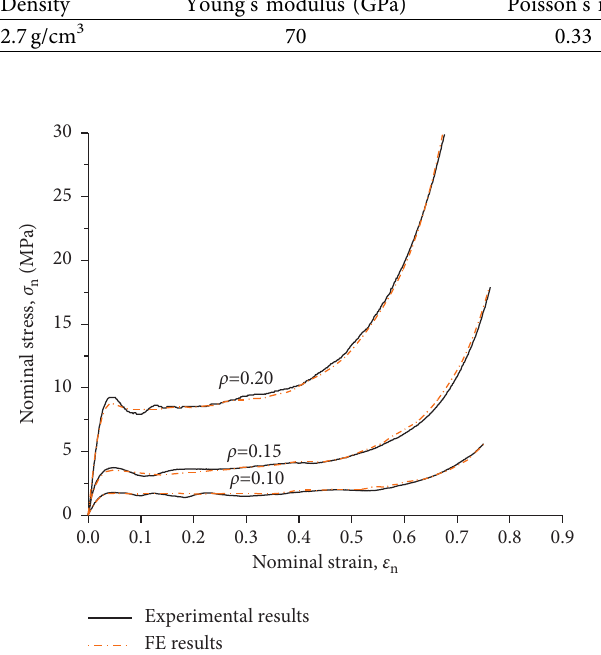
Figure 10: Uniaxial compression results of experiments and simulations.